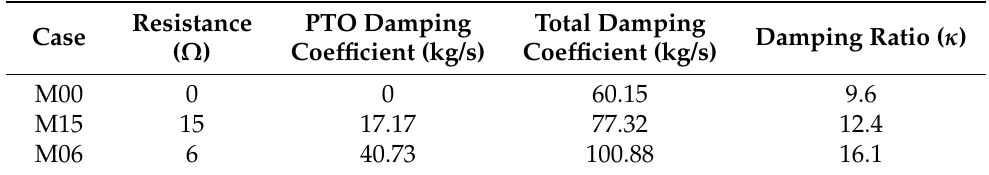
Table 2. Free decay test of single HPA with PTO damping.